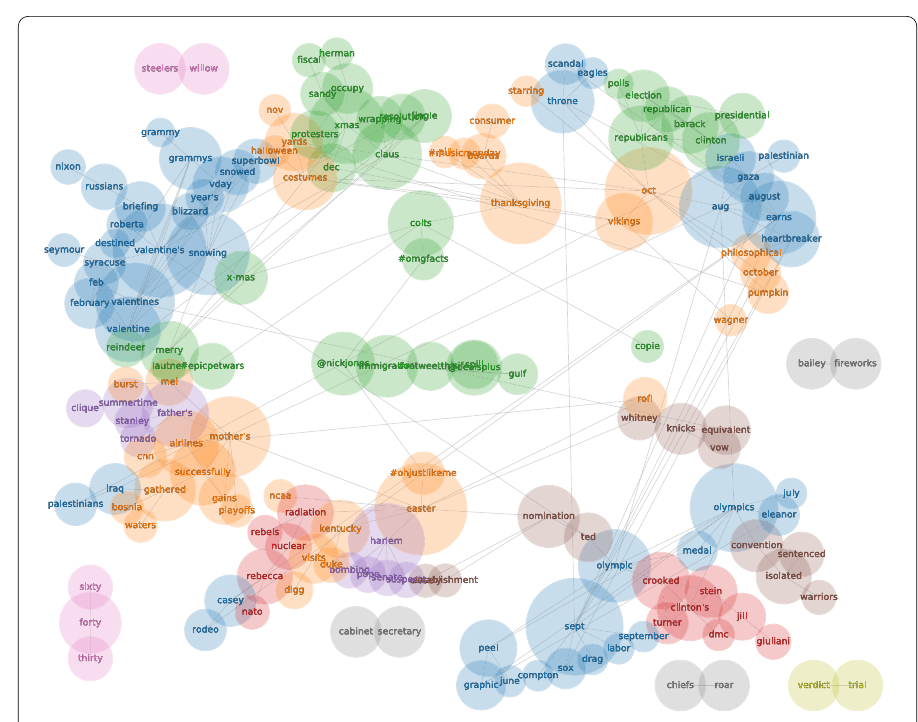
Figure 16 Topic network inferred from weighted spike indicator functions. At each point in time, words are ranked according to the value of their weighted spike indicator function and the top k words are taken and (cid:6) (cid:5) k additional edges in the network; if the edge between words i and j linked pairwise for an upper bound of 2 already exists, the weight of the edge is incremented. The edge weight increment at time t is given by , the average of the weighted spike indicator for words i and j , with the total edge weight thus w ij , t = Ri , t + Rj , t (cid:4) 2 given by w ij = t w ij , t . After initial construction, the backbone of the network is extracted using the method of Serrano etal. [97]. The network is pruned further by retaining only those nodes i , j and edges e ij for which w ij is above the p th percentile of all edge weights in the backboned network. The network displayed here is constructed by setting k = 20 and p = 50, where size of the node indicates normalized page rank. Topics are associated with distinct communities, found using the modularity algorithm of Clauset etal.